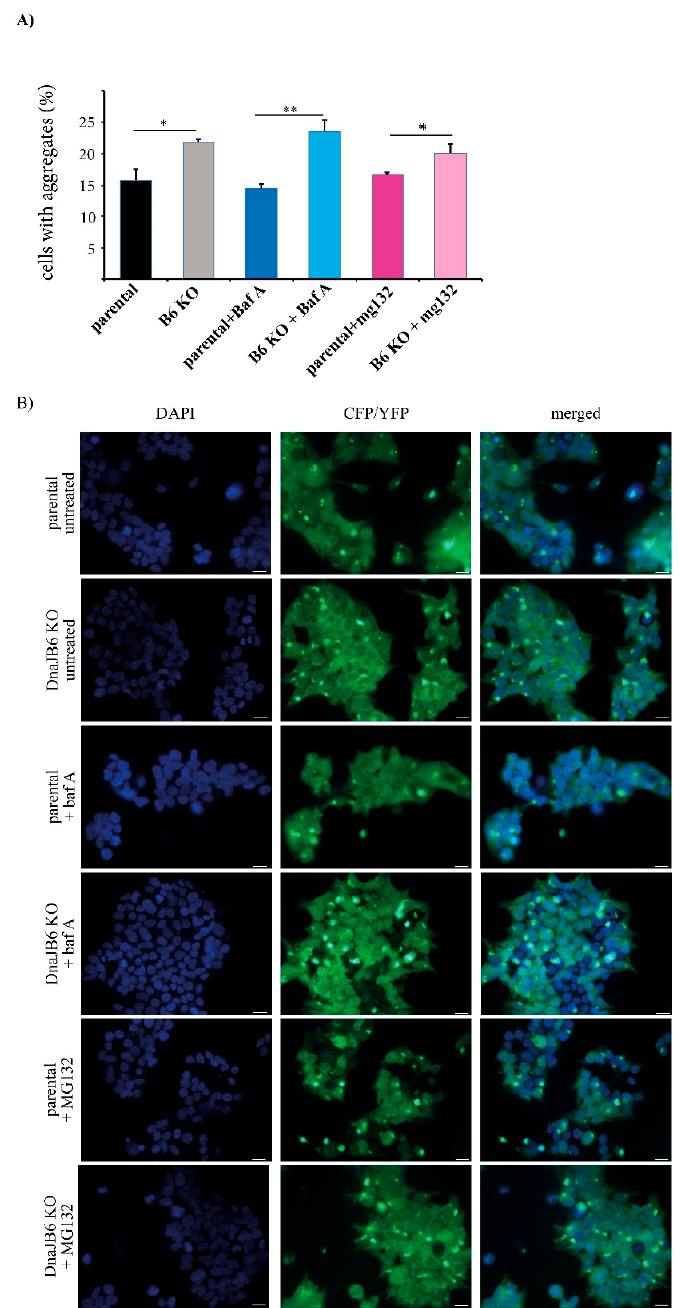
Figure 4. E ff ect of the lysosomal or proteasomal inhibitor treatment on the α -Syn PFF-induced aggregation of α -Syn in α -Syn CFP / YFP HEK293 cells analyzed by immunofluorescence microscopy. ( A ) Quantification of the percentage of DAPI-positive parental and DNAJB6 KO cells displaying CFP / YFP positive aggregates as counted using flourescence microscopy (15.8 ± 0.962; 21.9 ± 0.233; 14.5 ± 0.472; 23.5 ± 1.11; 16.6 ± 0.218; 20.1 ± 0.837). The cells were transfected with 10 nM α -Syn PFFs for 48 h, and treated (or not) with 100 nM of bafilomycin A or 25 µ M of MG132 for 2 h. ( B ) Representative pictures of the fixed parental and DNAJB6 KO α -Syn FRET HEK293 cells and DAPI stained after three days of culture following transfection with 10 nM of α -Syn PFFs for 48 h. The cells were either not treated (untreated), or treated with 100 nM bafilomycin A for 2 h or 25 µ M MG132 for 2 h. Magnification 40 × . Data were analyzed by the Student’s t -test and are represented as mean ± SD: * p < 0.05; ** p < 0.01 ( n = 3). Scalebar: 20 µ